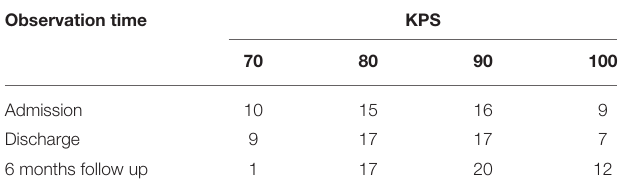
TABLE 1 | Visualization effect by fluorescence. Group